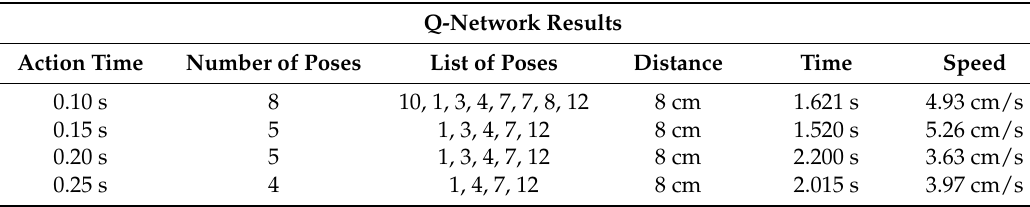
Table 3. Q-network Results.